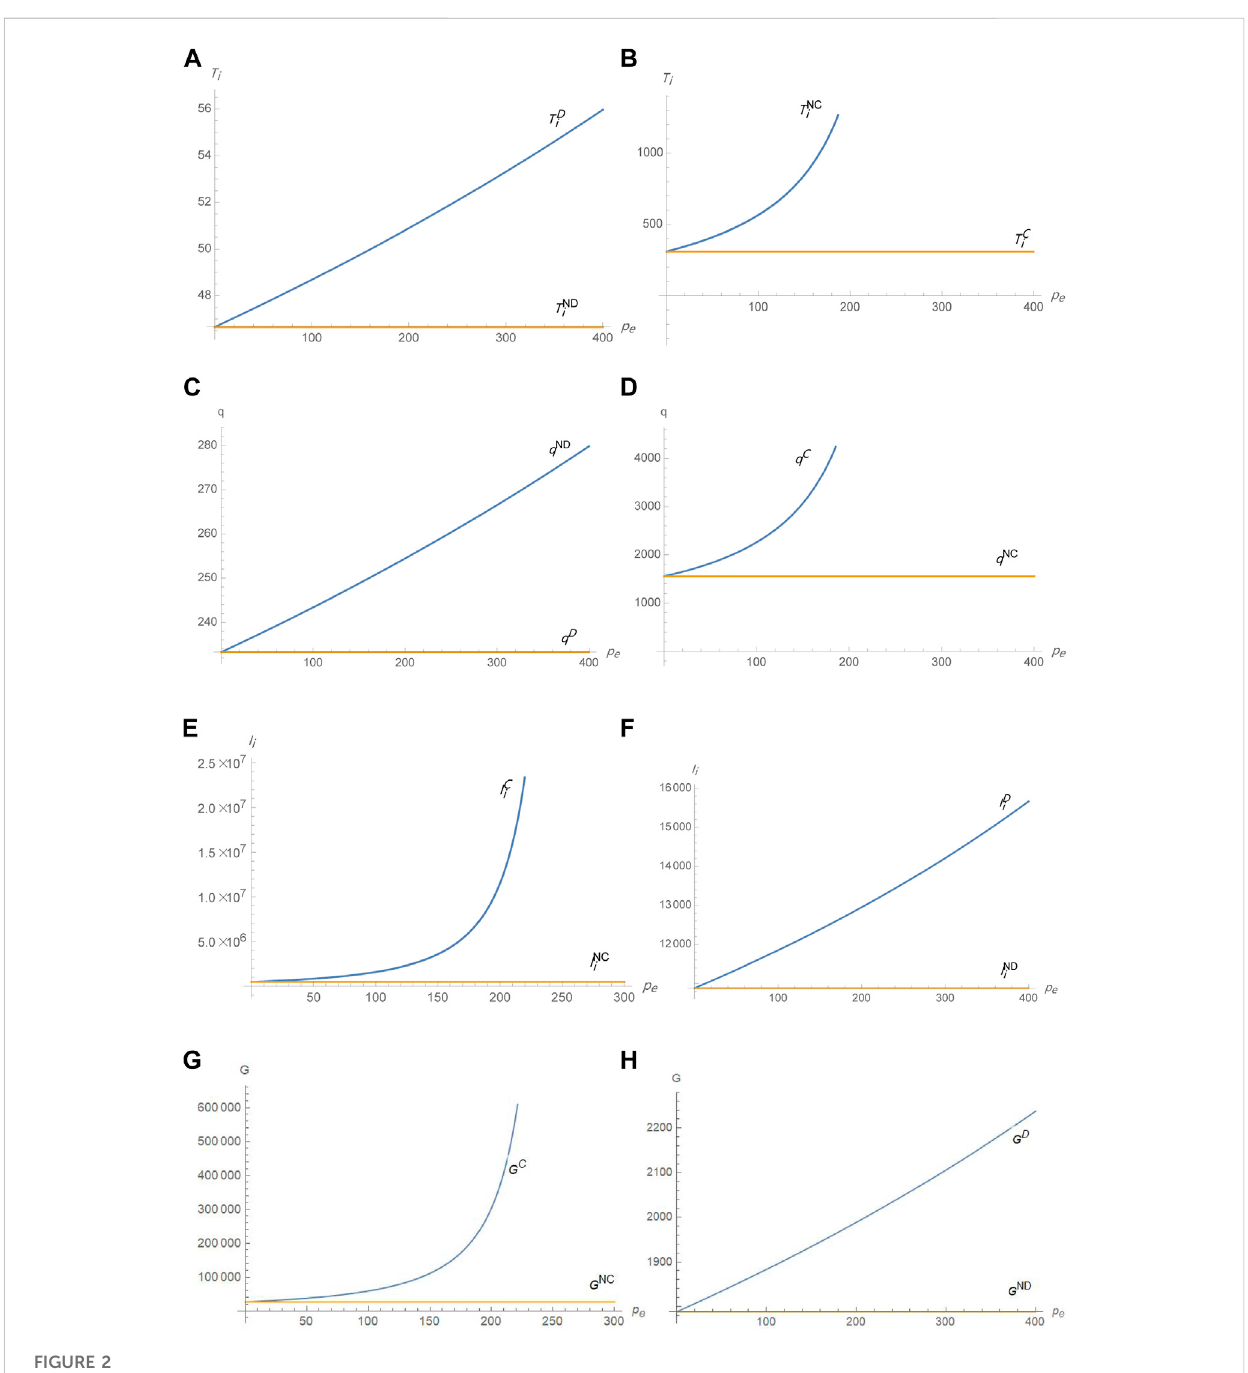
FIGURE 2 Impact of credit prices on the optimal